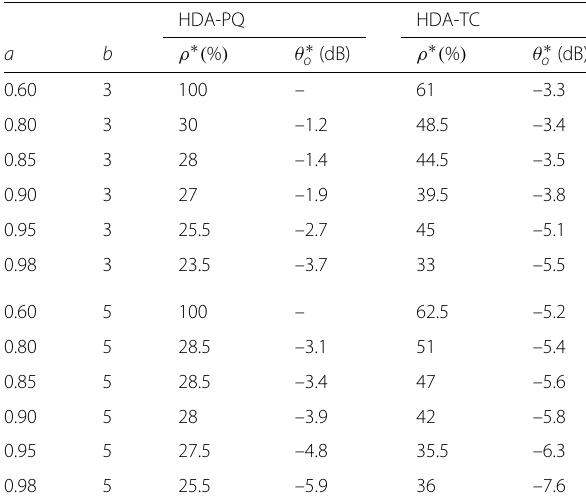
Table 2 The power allocations and outage CSNRs of HDA-PQ and HDA-TC systems shown in Fig. 5 ( left ) HDA-PQ HDA-TC